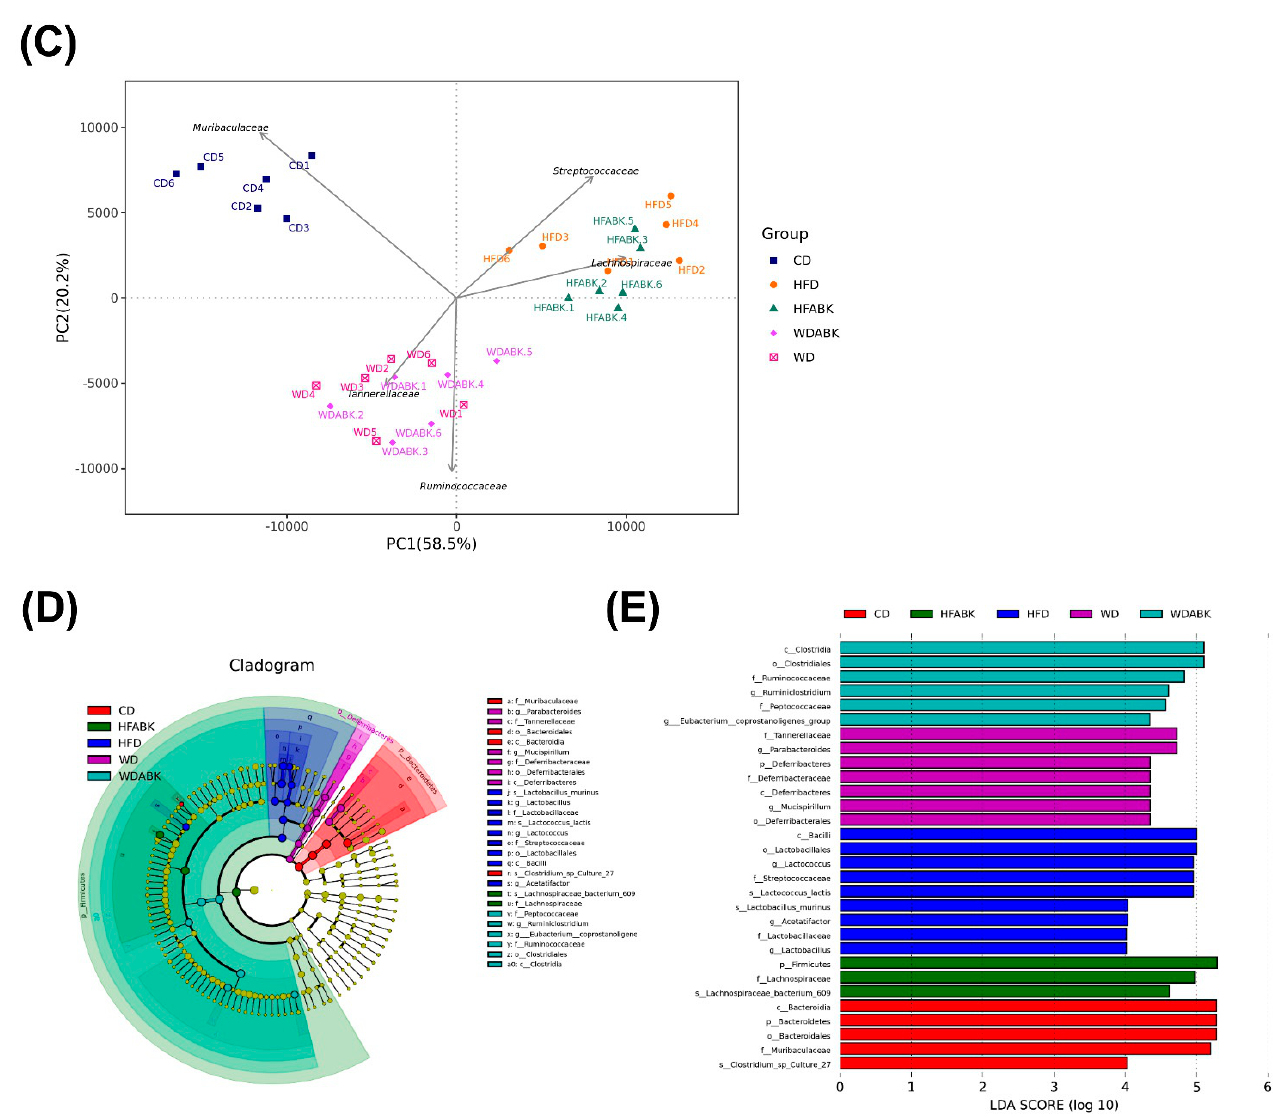
Figure 7. Effect of AB-Kefir on the gut microbiota composition in HFD- and WD-fed mice. ( A ) ACE, ( B ) Chao1 richness estimator, and ( C ) PCA plot of gut microbiota at the family level and the first two principal components, PC1 and PC2, are plotted. The five largest PCA loadings of taxa are indicated by arrows next to their genus names. ( D , E ) LEfSe comparison of the gut microbiota between CD, HFD, HFABK, WD, and WDABK groups. Each point represents one sample (n = 6 per group).